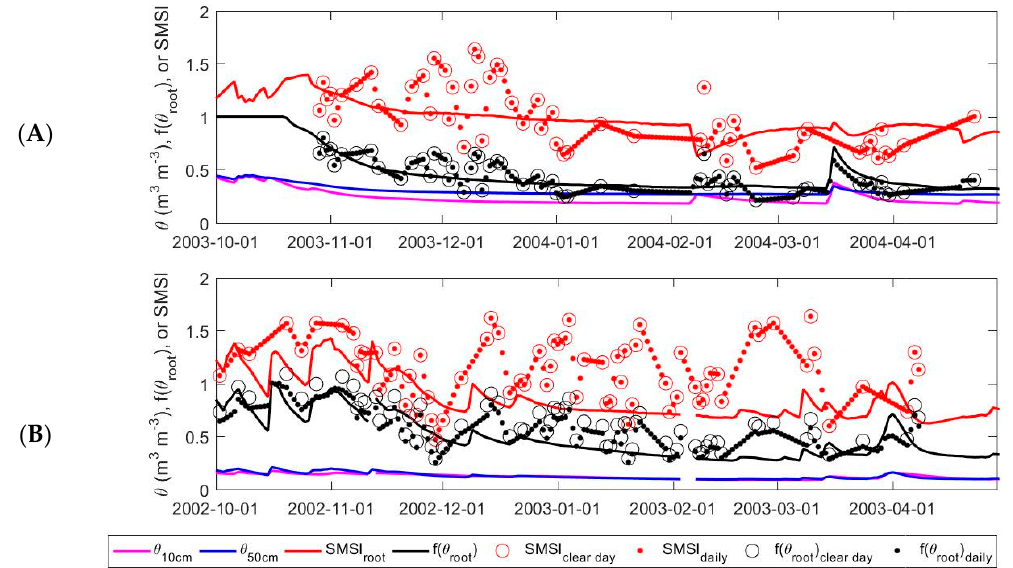
Figure 2. Time series of soil moisture stress index (SMSI) and f ( θ root ) at ( A ) MKL site and ( B ) SKR site. Soil moisture at 10 cm ( θ 10cm ) and 50 cm ( θ 50cm ) depths are also shown.